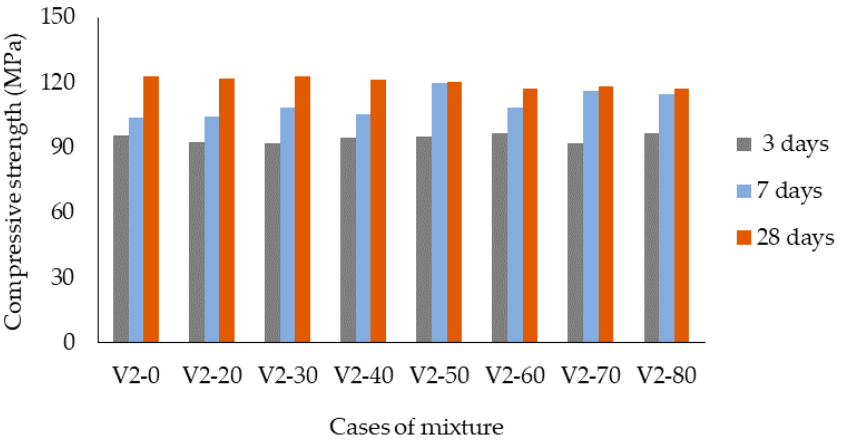
Figure 7. Compressive strength of V2 group.